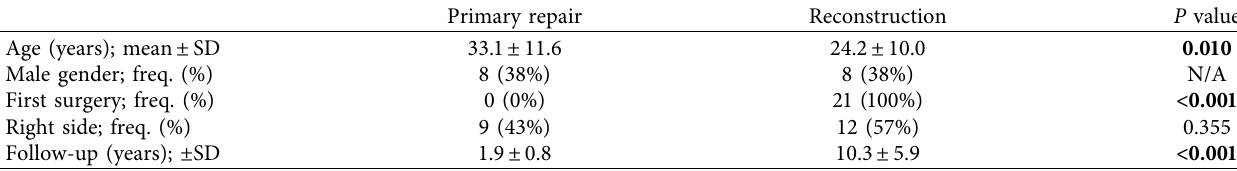
Table 1: Patient demographics of patients treated with primary ACL repair and ACL reconstruction.